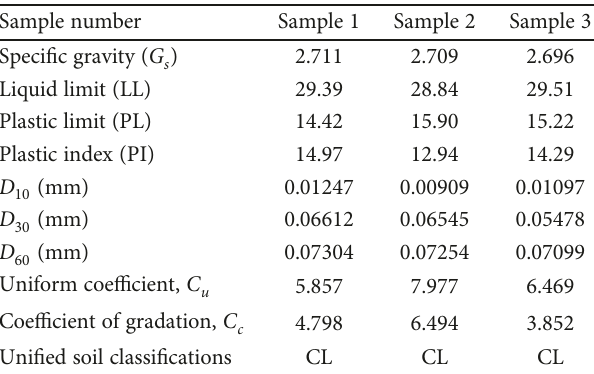
Figure 7: Soil sampling at the sliding slope. Table 3: Physical properties of local landslide